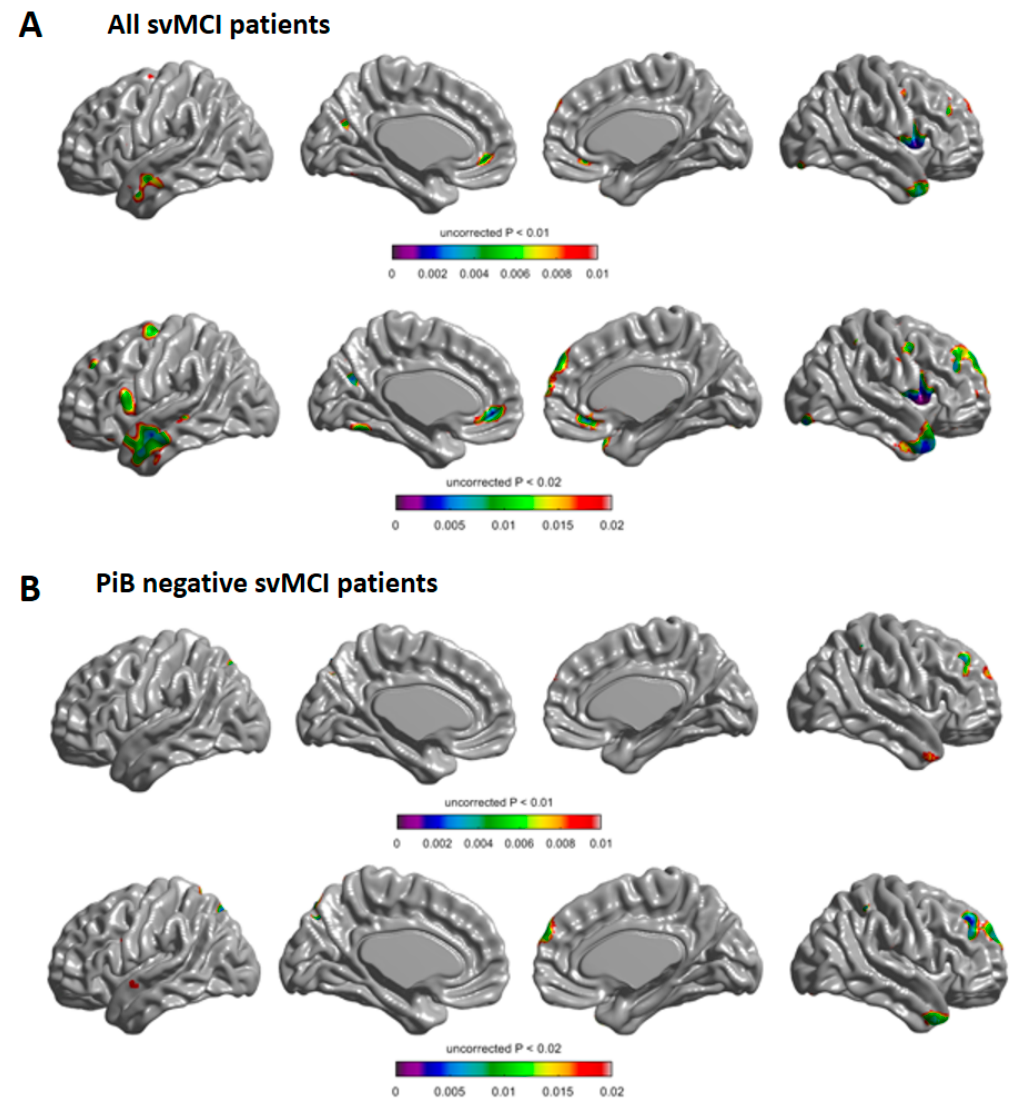
Figure 1. Longitudinal change of cortical thickness in the white matter hyperintensity (WMH) progression group compared with the WMH regression group in all of the subcortical vascular mild cognitive impairment (svMCI) patients ( A ) and in PiB negative svMCI patients ( B ). Compared